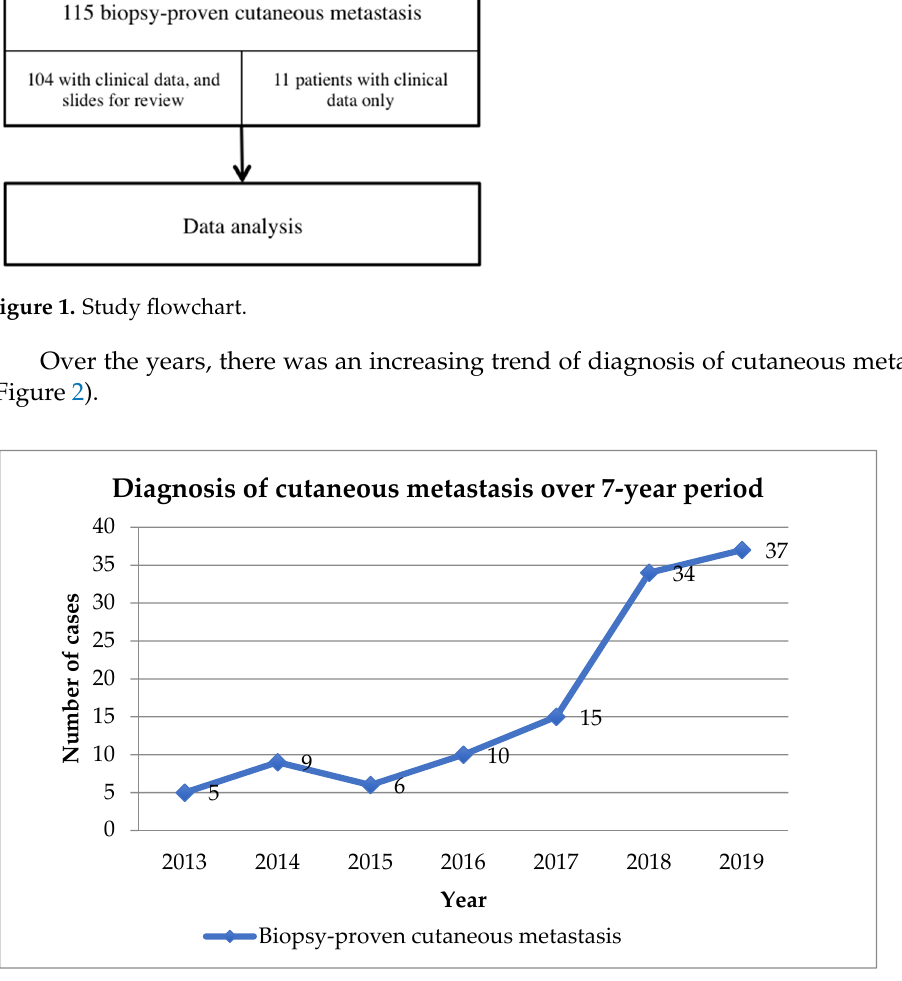
Figure 2. Diagnosis of cutaneous metastasis at the UP-PGH over the 7-year study period.